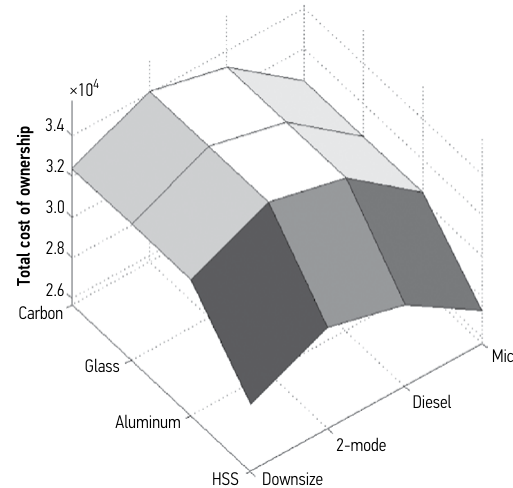
Fig. 14. Optimal lightweighting and efficiency implementation using discrete optimization for the 16 cost scenarios